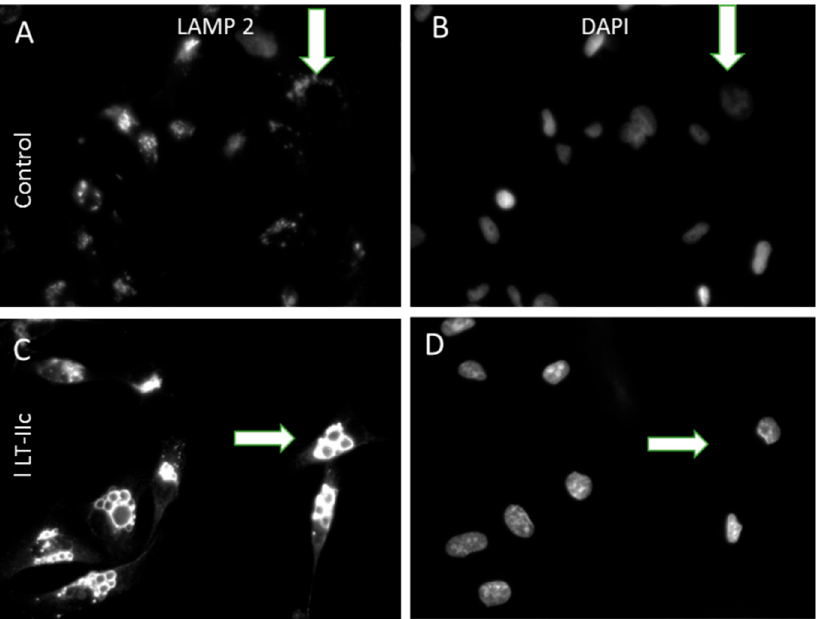
Figure 4. Enlarged intracellular vacuoles induced by LT-IIc are positive for LAMP-2. ( A , B ): Untreated MDA-MB-231 cells display punctate cytoplasmic staining for small lysosomes expressing LAMP-2 ( A , arrow); DAPI staining for nuclei in same field ( B ). ( C , D ): LT-IIc-treated cells at 6 h possess multiple enlarged LAMP-2-stained bodies ( C , arrow); DAPI staining of the same field ( D ). All images were taken under a 40 × objective, using identical manual exposure times for control versus treated cells.